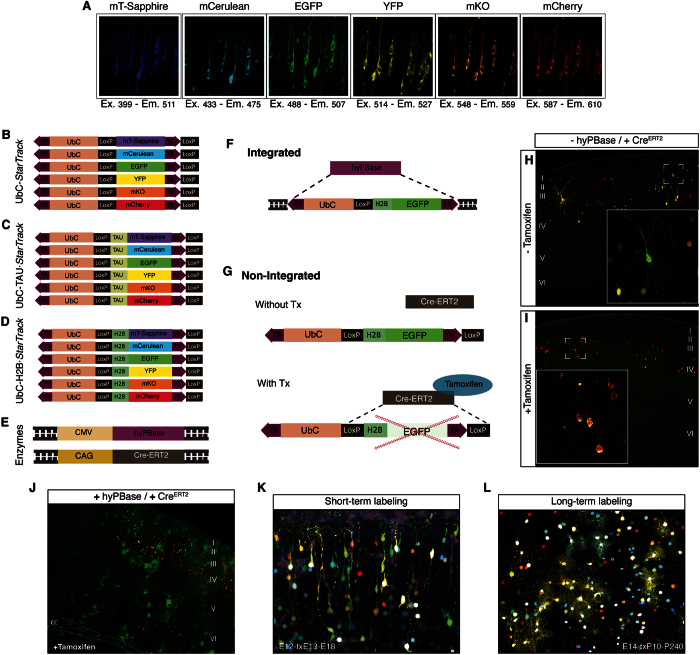
UbC-StarTrack design.(A) Fluorescent reporters: mT-Sapphire, mCerulean, Enhanced green fluorescent protein (EGFP), Yellow fluorescent protein (YFP), monomeric Kusabira Orange (mKO) and mCherry. Spectral profiles for the single fluorophores: Ex, Major excitation peak; Em, Major emission peak. (B) Scheme of the six ubiquitous constructs with the different fluorescent proteins expressed in the cytoplasm: UbC-StarTrack. (C) Scheme of the six constructs with the different TAU-fluorescent fusion proteins: UbC-TAU·StarTrack. (D) Scheme of the six ubiquitous constructs encoding the different H2B-fluorescent fusion proteins: UbC-H2B·StarTrack. (E) Hyperactive version of the PiggyBac transposase (hyPBase) and an inducible Cre recombinase (Cre-ERT2) were added to the UbC-StarTrack electroporation mixture. Ubiquitous promoters drove the expression of both constructs. (F) hyPBase introduces several copies of constructs into the cell genome after electroporation. (G) Cre recombinase activated by tamoxifen (Tx) deletes the episomal copies of vectors (not integrated by the transposase). (H) IUE (E14) of UbC-EGFPflox, UbC-Cherry and CreERT2 in the absence of the transposase (hyPBase). Without Tx administration, brains processed at P20 displayed green and red-labeled cells. (I) IUE (E14) of UbC-EGFPflox, UbC-Cherry and CreERT2 in the absence of transposase (hyPBase). After Tx administration, there were no traces of the GFP protein in brains processed at P20. CreERT2 activation by Tx successfully inhibits floxed non-integrated constructs. (J) Co-electroporation of CreERT2, UbC-EGFPflox and UbC-mCherry in the presence of the hyPBase. Genomic integration of EGFP floxed plasmids permanently labels cells with a high rate of division. Green cells, corresponding to glial lineages located within the corpus callosum (cc) and cortical areas. (K) Short term labeling following Tx administration one day after IUE (E12) of the UbC-TAU·StarTrack mixture and analyzing the brains five days later. (L) After UbC-StarTrack and UbC-H2B·StarTrack IUE (E12), fluorescent reporters remained brightly expressed 8 months later (P240) having administered Tx to pups at P10.